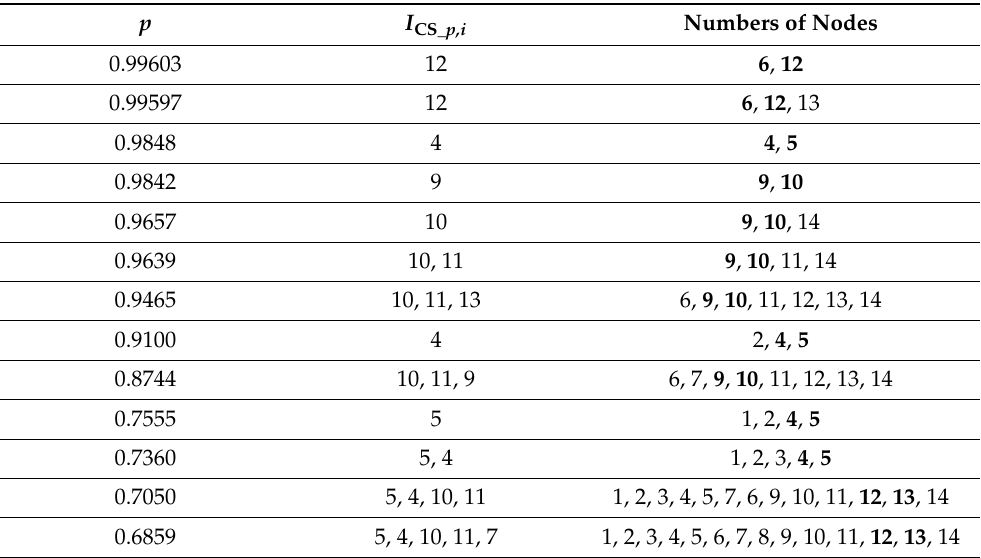
Table 5. Consistent areas of the considered power system defined by (16), and characteristics of these areas.